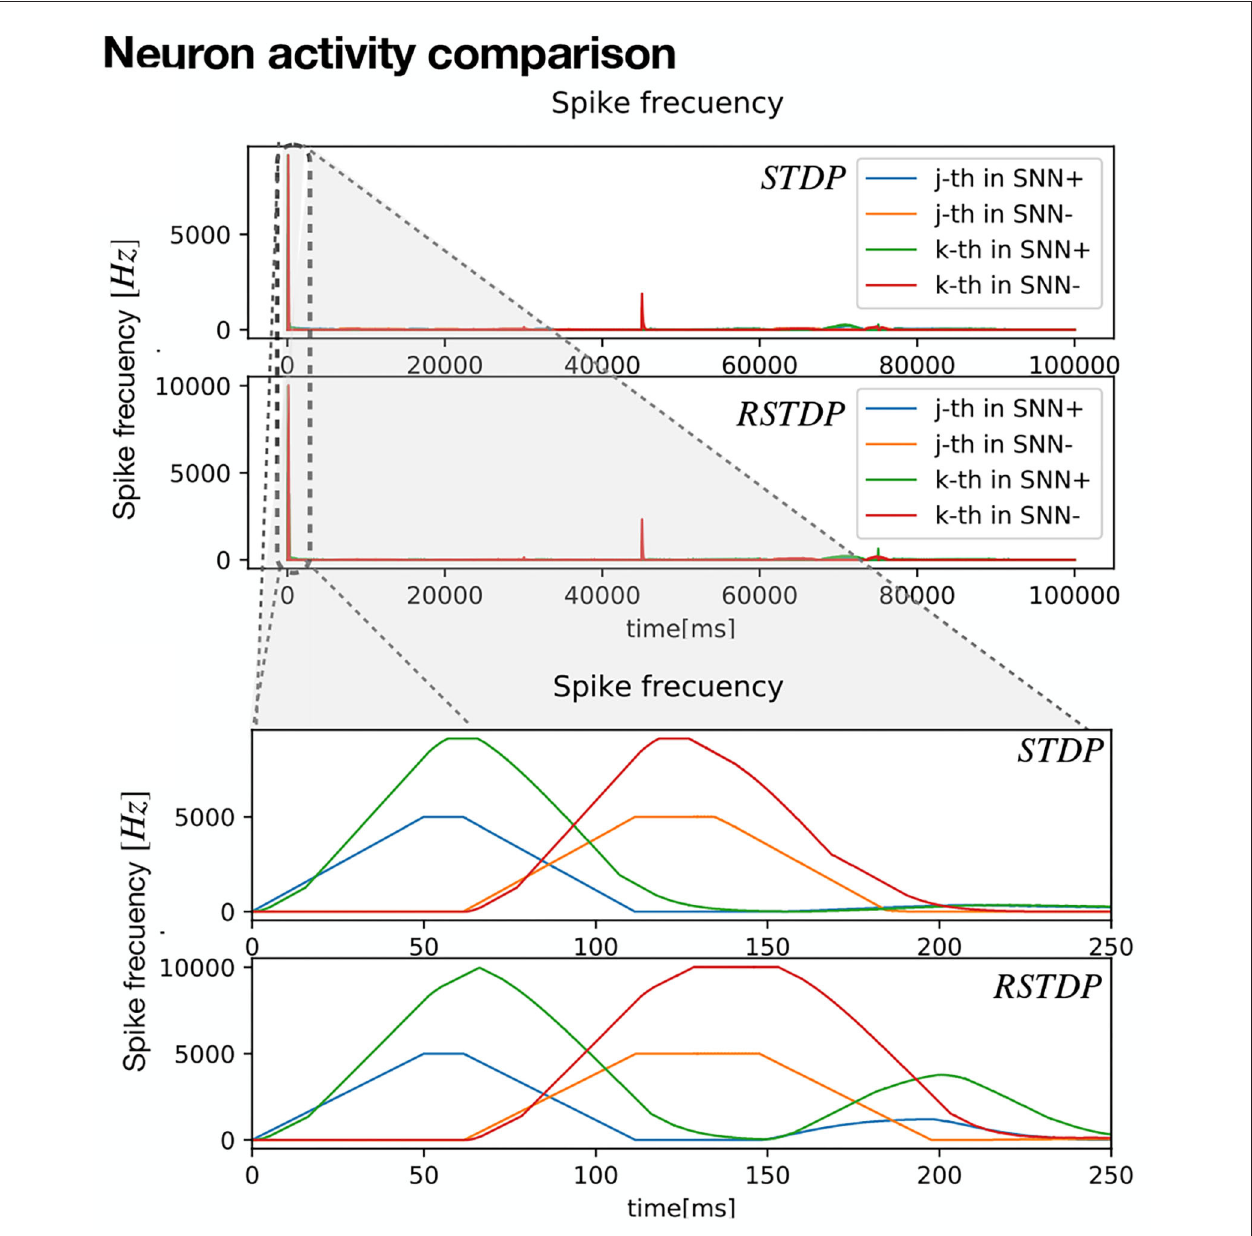
FIGURE 7 | Neuron activity for 1-link controller pendulum. First, t = 100 s of the entire control execution is shown, for SNN-STDP (Up) and SNN-RSTDP (down). A zoom at t = 0 ms − 250 ms is shown at the highest neuron